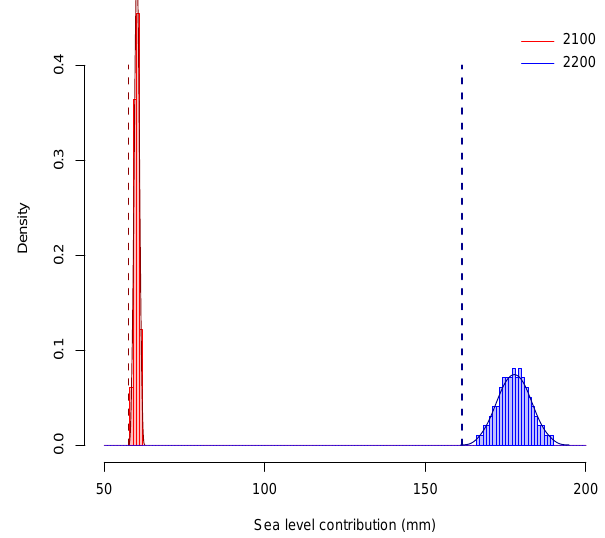
Fig. 4. GISM-SIA projections for sea level contribution in 2100 (red) and 2200 (blue): no elevation feedback (dashed vertical line) and with feedback (histograms and density